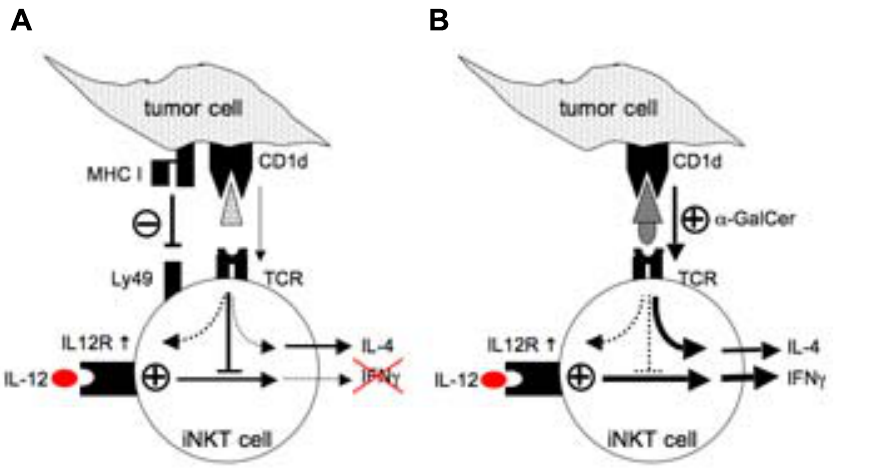
Figure 7. Proposed working model of tumor cell-induced functional iNKT cell defects in TRAMP prostate cancer. A. Tumor cells deliver 2 signals to iNKT cells: CD1d:TCR-mediated signal is sufficient for a partial activation, i.e. the up-regulation of activation markers and secretion of IL-4 by iNKT cells. MHC-I:Ly49 interaction inhibits enhancement of IFN c production by iNKT cells. B. Stimulation with high-affinity ligand a -GalCer and IL- 12 bypasses tumor cell-induced block of IFN c production.